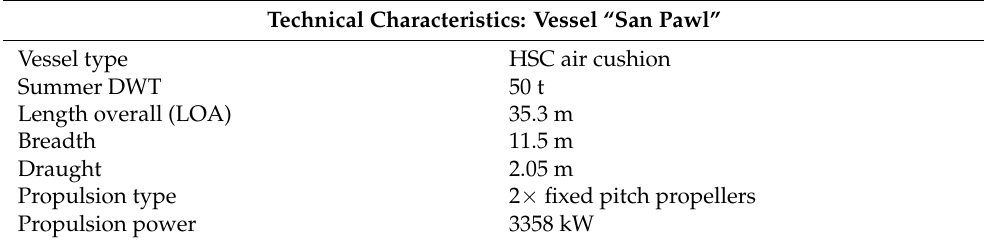
Table 4. Technical characteristics of the reference vessel “San Pawl”.